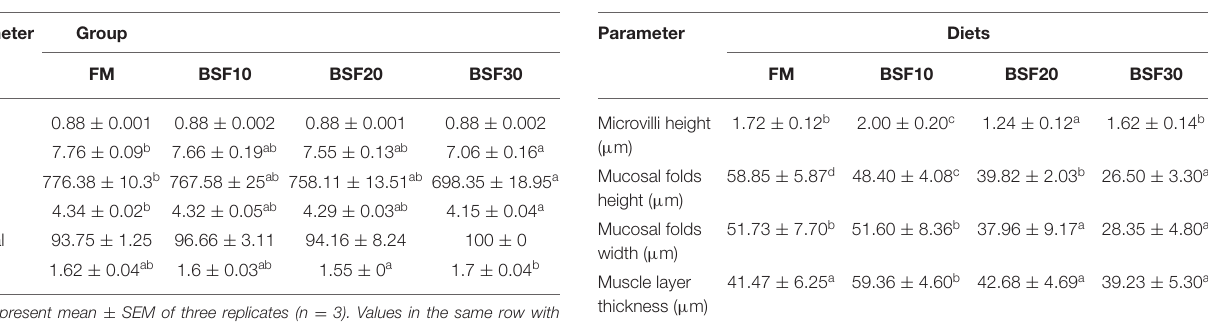
21.0 (SPSS, Chicago, IL, United States). A probability value of